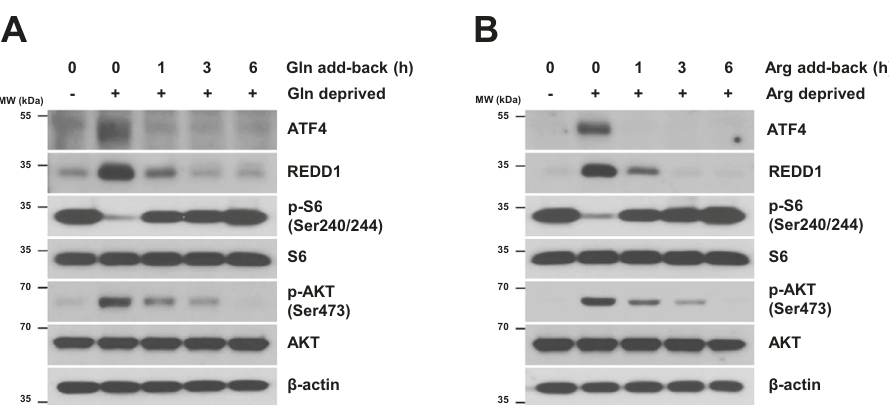
Fig. 5 Replenishment of glutamine or arginine in the medium reverses the mTORC1 inhibition and mTORC2 activation induced by deprivation of glutamine or arginine. A , B H1299 cells deprived of glutamine or arginine for 24 h were supplemented with 300 mg/L glutamine or 200 mg/L arginine for the indicated times. The levels of the indicated proteins were measured by western blot analysis.